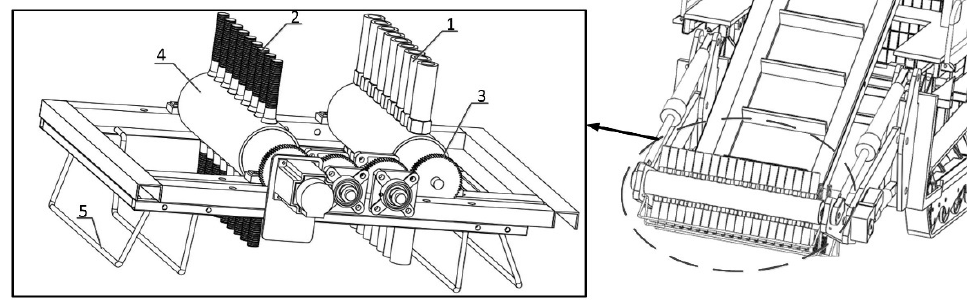
Figure 6. Multi-flexible-fingered roller of pineapple harvester. 1. Right flexible finger 2. Left flexible